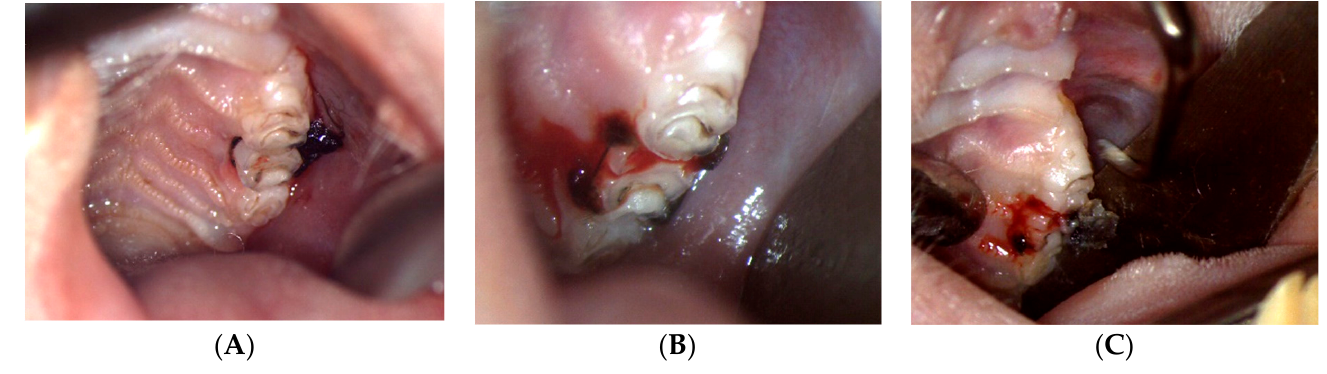
Figure 2. Clinical aspect of the gingiva at the end of the experiment. ( A )—presence of the ligature at the end of the experiment; ( B )—bleeding on probing at ligature removal; ( C )—presence of inflammation, food debris and necrotic tissue.